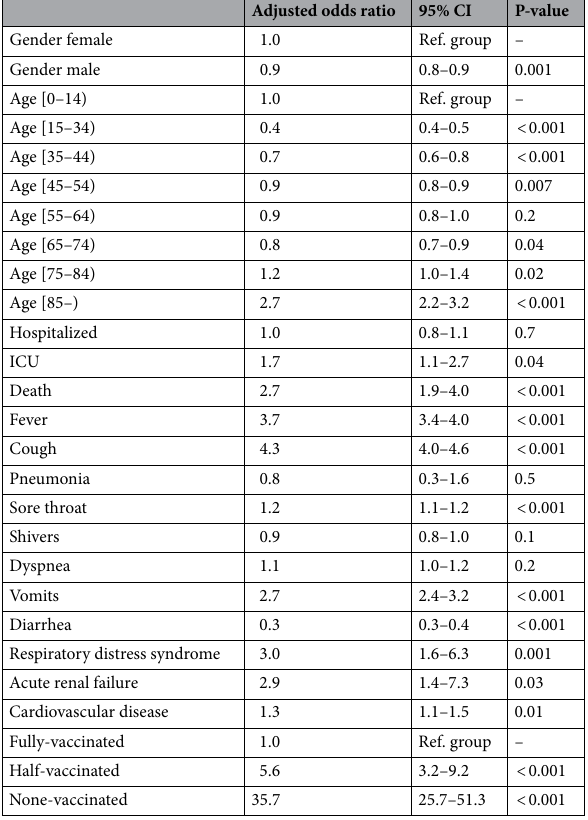
Table 2. Logistic regression analysis of COVID-19 cases between the predominance of Alpha and Delta variants in Lleida region (Spain). In the logistic regression analysis, the reference category of the dependent variable (Alpha or Delta variant period) was the Delta variant period. CI Confidence Intervals, Ref. group Reference Group, ICU Intensive Care Unit, RDS Respiratory Distress